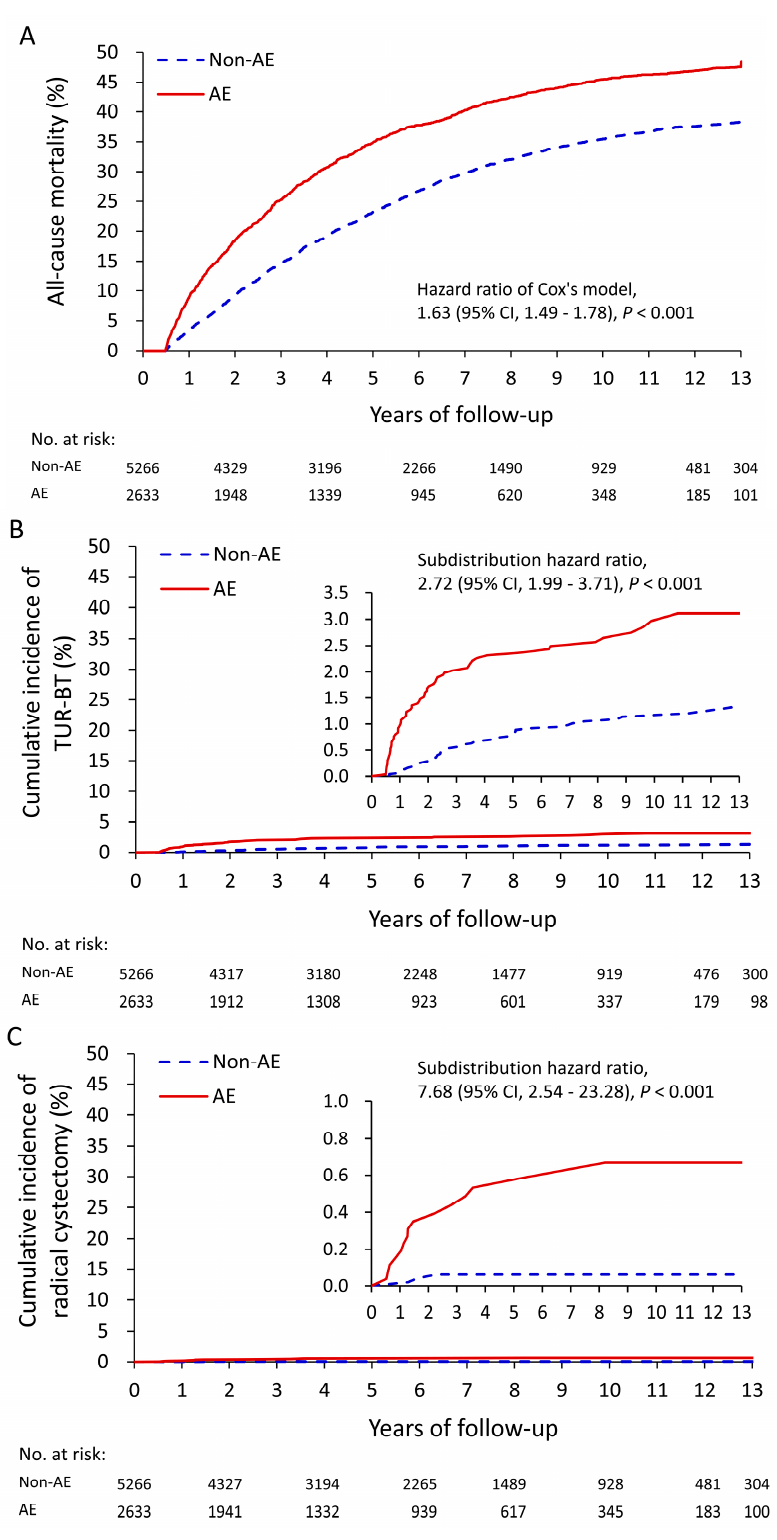
Figure 3. Unadjusted cumulative event rate of all-cause mortality (A), cumulative incidence of transurethral resection of bladder tumor (B), and cumulative incidence of radical cystectomy (C) in patients with and without adverse events during the first six-month follow-up in the medication-only cohort.